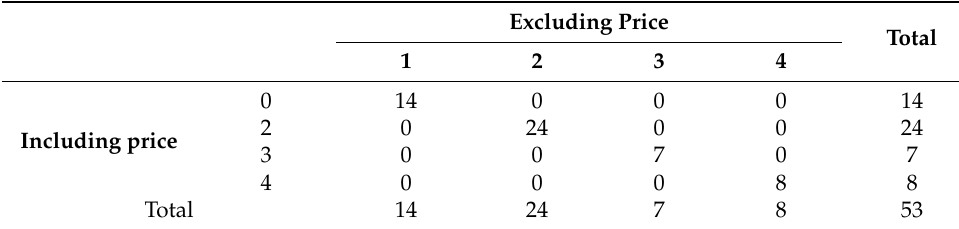
Table 11. Classification comparison for 4